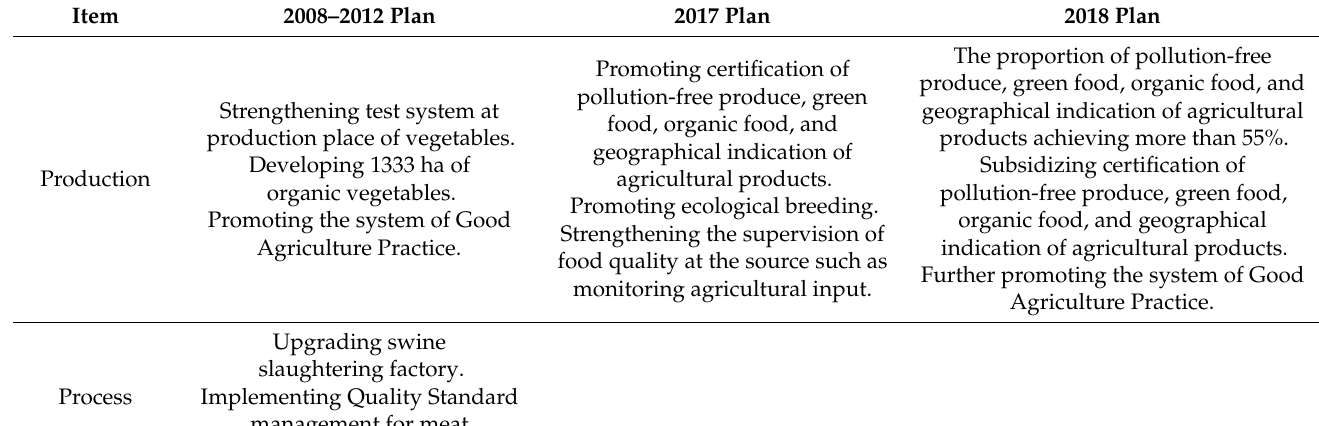
Table 1. Food safety strategies in Nanjing plans. (Sources: Complied by